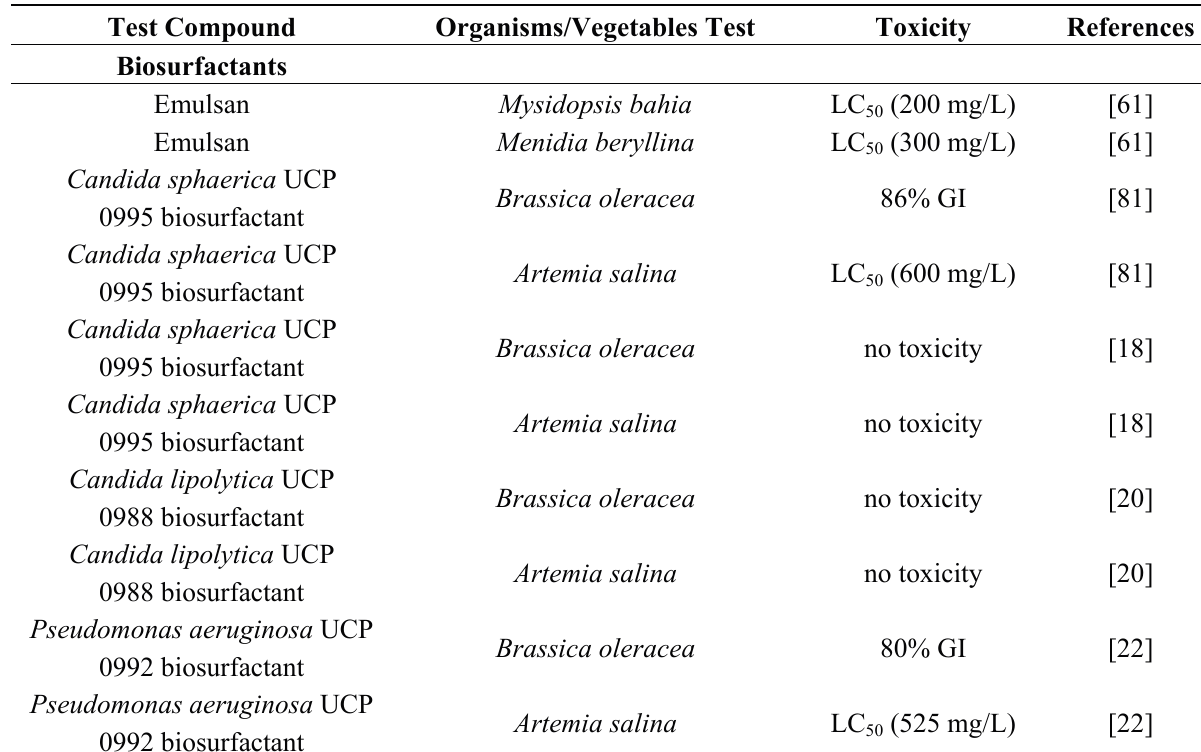
Table 6. Results of toxicity tests of (bio)surfactants, dispersants, crude oils, and dispersant/crude oil mixtures to vegetables and